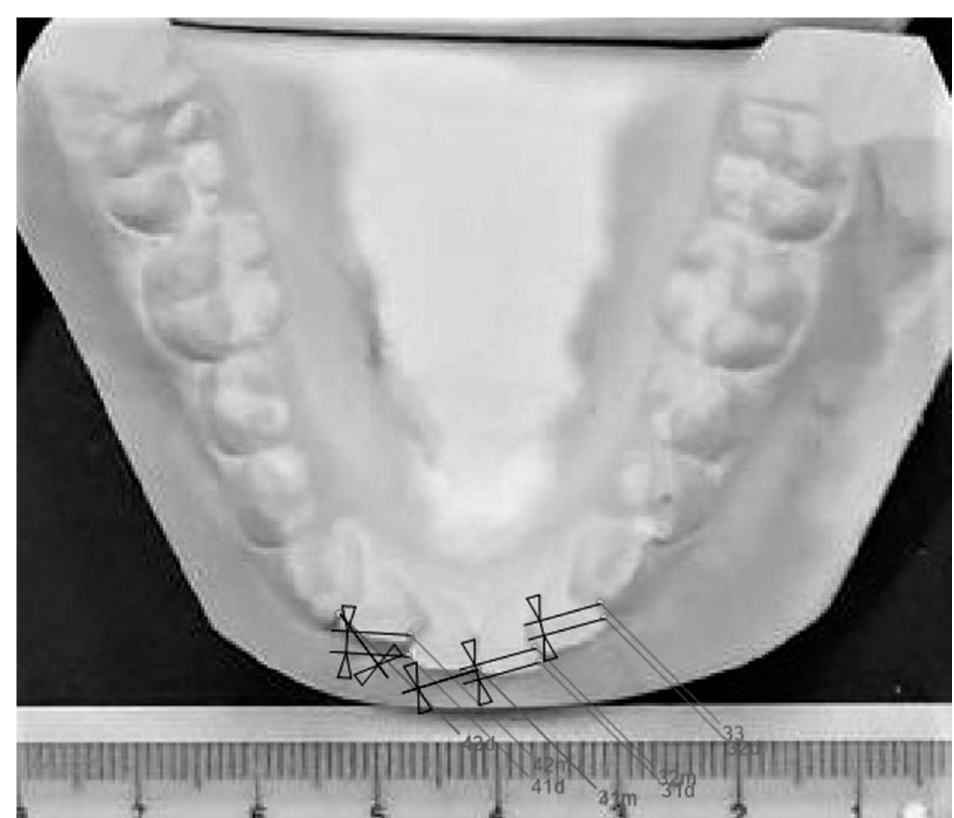
Figure 2. Little’s irregularity index measurement in AudaxCeph software.